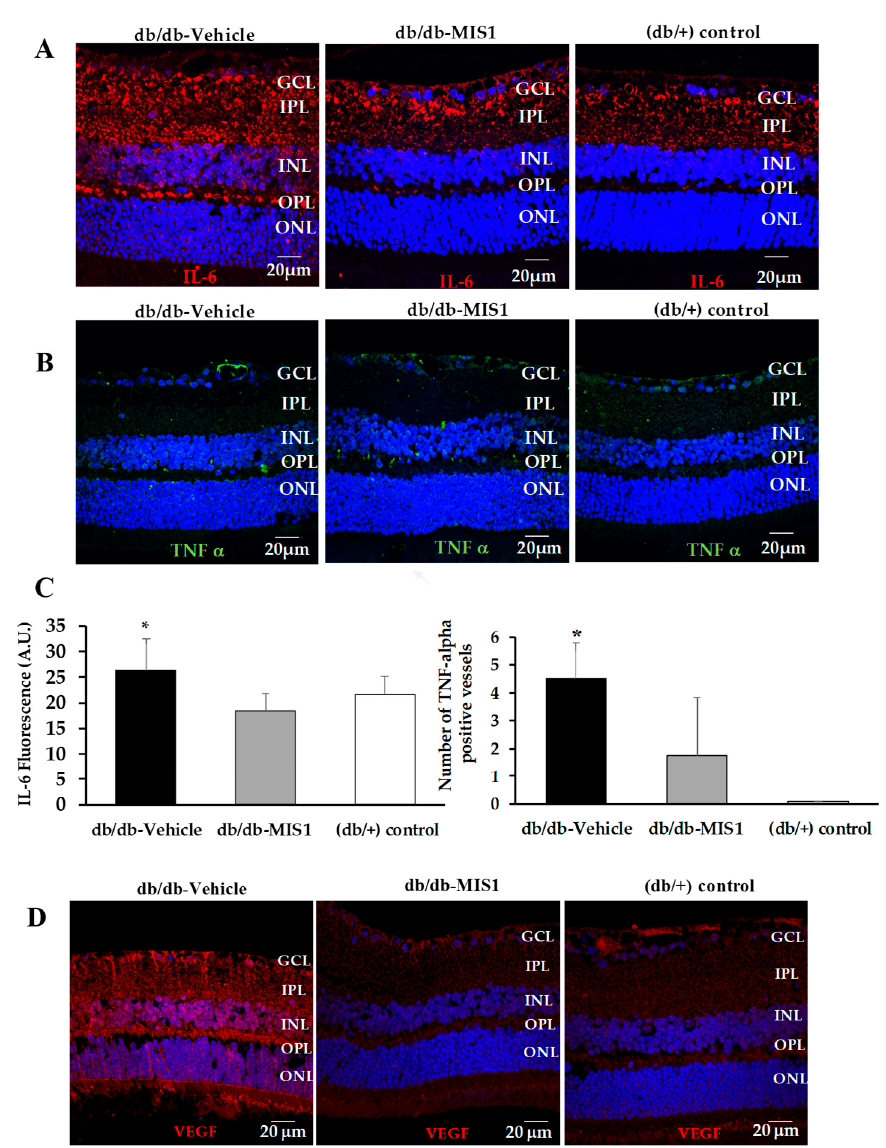
Figure 8. Effect of topical administration (eye drops) of SOCS1 peptidomimetic (MIS1) on IL-6 ( A , C ), TNF- α ( B , C ) and VEGF ( D ). n = 7 retinas per group. AU: arbitrary units. Data are expressed as mean ± SD. * p < 0.05 in comparison with the other groups. ONL: outer nuclear layer; OPL: outer plexiform layer; INL: inner nuclear layer; IPL: inner plexiform layer; GCL: ganglion cell layer.